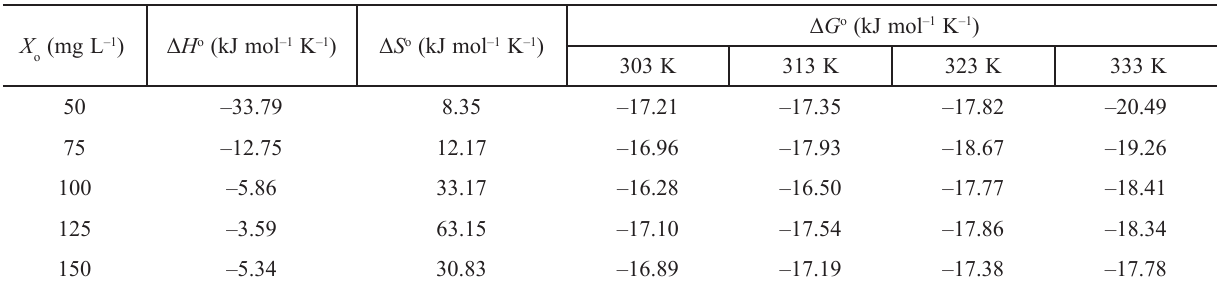
Table 5 – Thermodynamic parameters using classical statistical physics for 2-CP sorption onto RSAC (X t =125 min; RSAC dose = 1.25 g L –1 ; pH